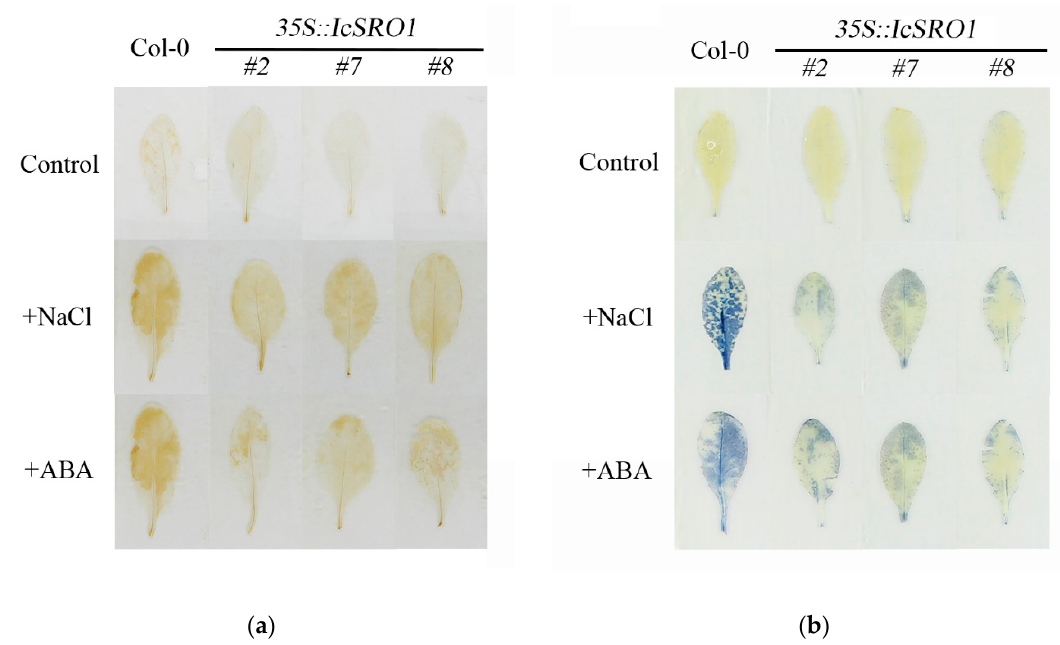
Figure 7. Accumulation of H 2 O 2 and O 2 − under stress conditions demonstrates more H 2 O 2 and O 2 − produced in the Col-0 than in the transgenic lines under salinity and drought stress. Histochemical staining assays were used to detect H 2 O 2 and O 2 − by DAB ( a ) or NBT ( b ) staining, respectively.